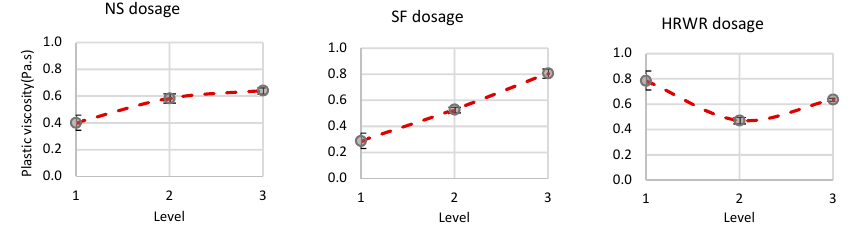
Figure 7. Influence of factors on plastic viscosity values.